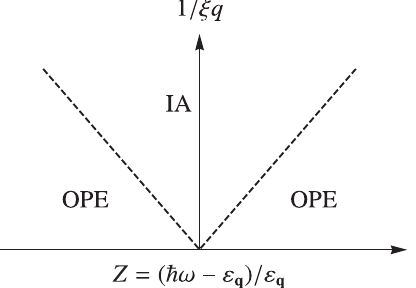
FIG. 1. Sketch of the asymptotic structure of the dynamic ~ ξ ≫ 1 structure factor at large momentum q and q j a j ≫ 1 , where ~ ξ is the characteristic length scale of the gas [such as k − 1 ffiffiffiffiffiffiffiffiffiffiffiffi n ¼ p 2 π mT ]. Note that this scaling does not ð 6 π 2 n Þ − 1 = 3 or λ T ¼ ℏ = a j ≫ 1 . Small deviations in energy from necessarily require k n j the single-particle peak of order O ð q Þ are described by the impulse approximation (IA), whose range of applicability shrinks with increasing momentum. Large-energy deviations of order O ð q 2 Þ are in turn described by the operator product expansion (OPE), which predicts asymmetric tails on the left- and right- hand side of the single-particle